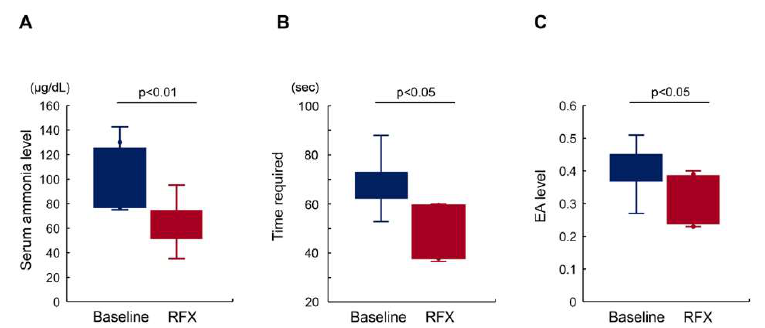
Figure 2. Effect of rifaximin on serum ammonia level, cognitive disturbance, and endotoxin activity (EA). ( A ) The mean serum ammonia levels among the patients who revealed high levels (>70 μg/dL) at baseline were significantly lowered 4 weeks after treatment with rifaximin (RFX). ( B ) Corresponding to serum ammonia levels, the mean time required for Number connection test-A (NCT-A) among patients who revealed prolongation (>50 s) at baseline was significantly shortened after treatment. ( C ) The mean endotoxin activity among patients who reported high levels (>0.4) at baseline significantly declined after treatment. Data are means ± SD.